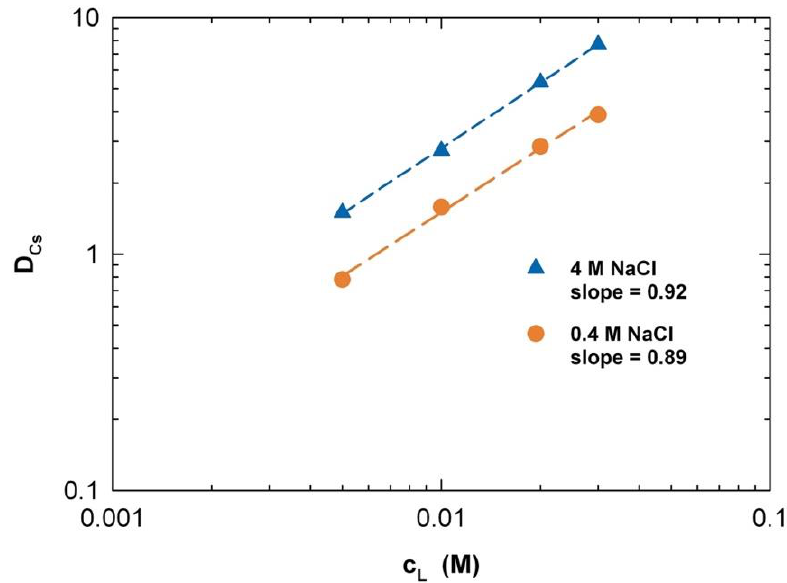
Figure 5. Cs + distribution ratios as a function of MAXCalix concentration. Organic phase, MAXCalix in 1-octanol. Aqueous phase, 4 M or 0.4 M NaCl + 0.001 M HCl + 137 Cs (10 kBq/mL).